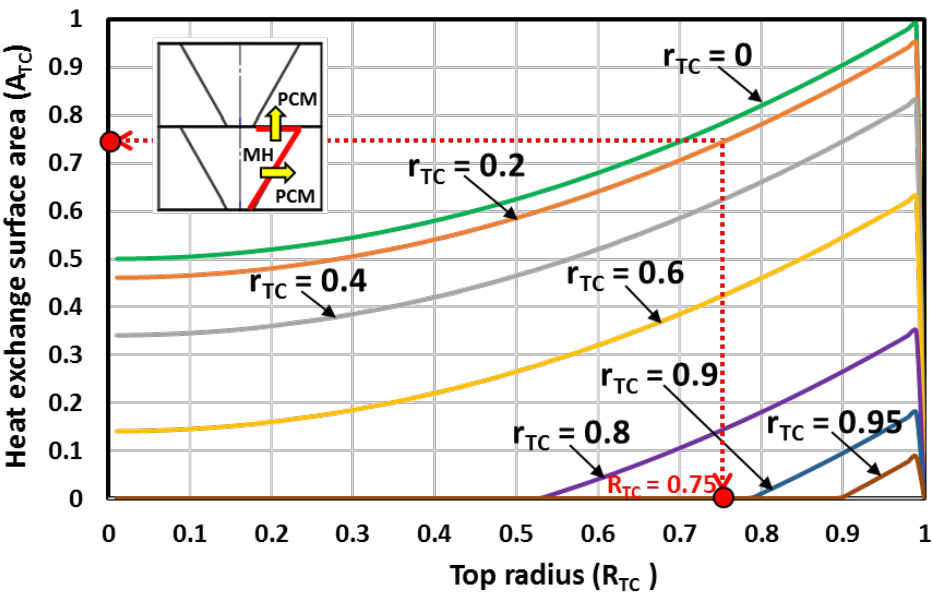
Figure 6. The heat exchange surface area between two MH-PCM stacked disks for different top and bottom radii.